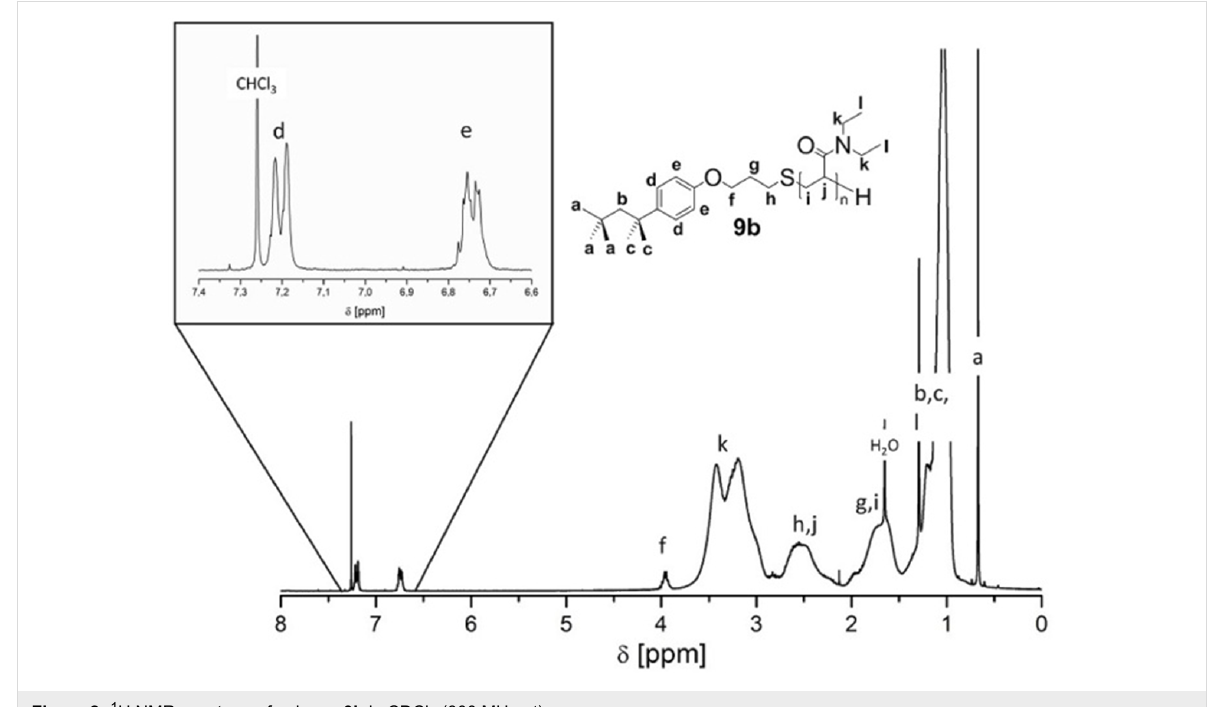
Figure 2: 1 H NMR spectrum of polymer 9b in CDCl 3 (300 MHz, rt).